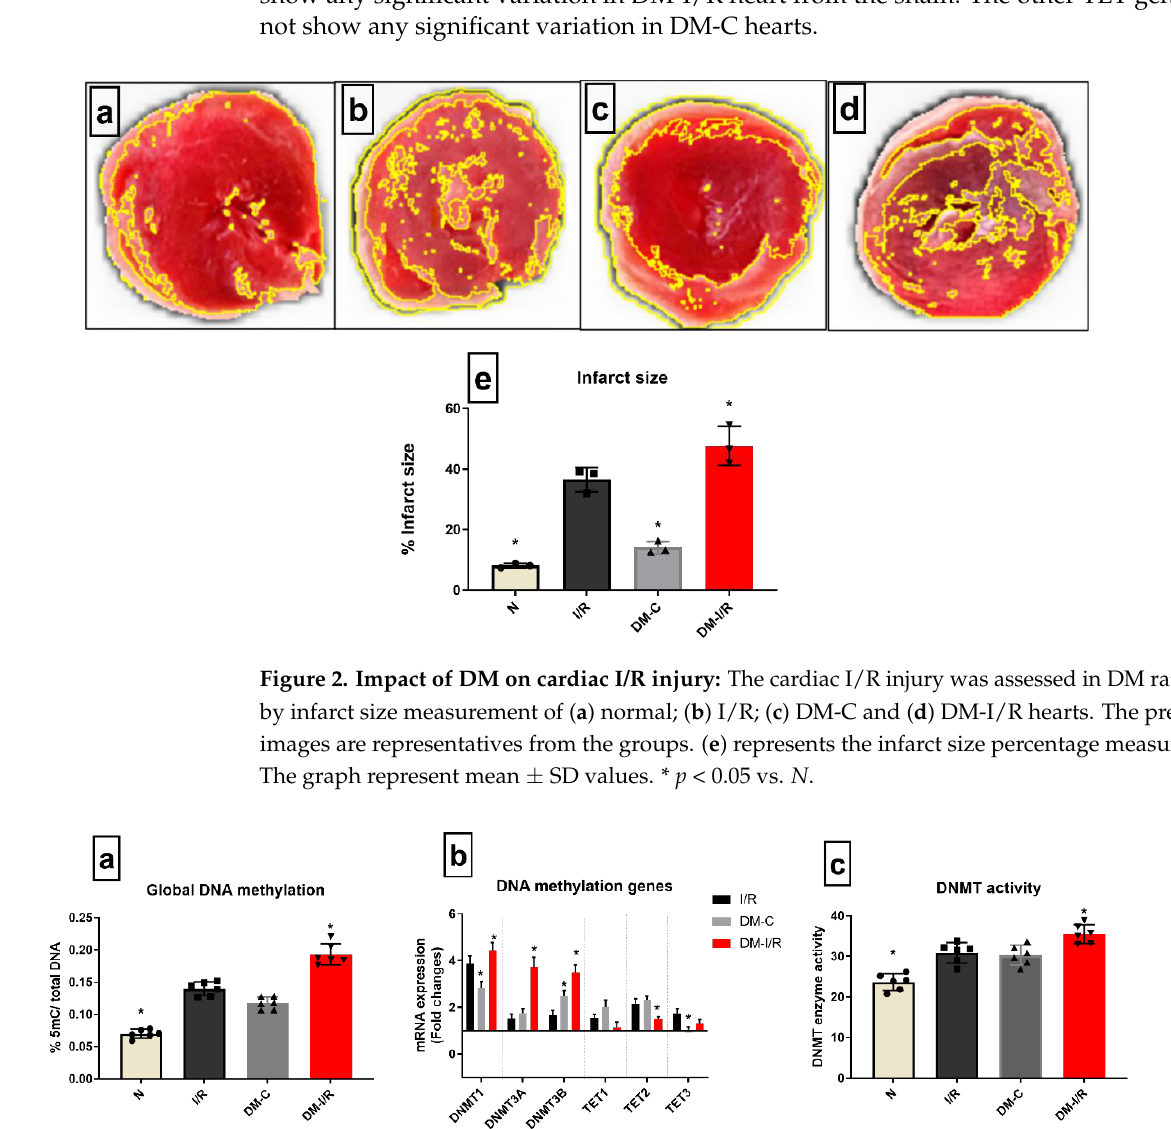
Table 3. Correlation data of global DNA methylation with the injury and mitochondrial function during cardiac I/R in diabetic rats: Pearson correlation analysis of global DNA methylation with the cardiac injury and hemodynamic parameters and the mitochondrial genes.